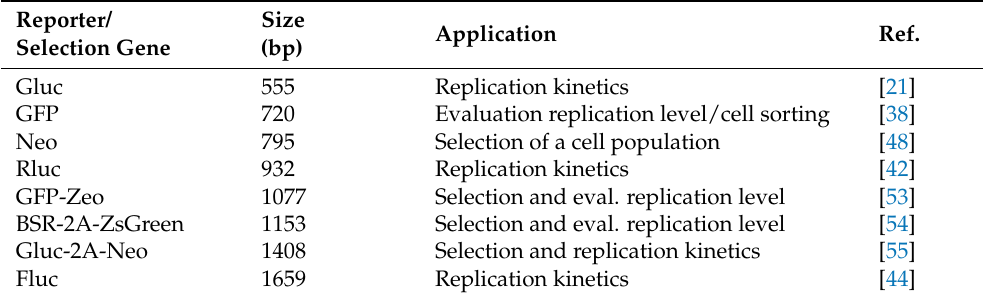
Table 1. Reporter and selection genes used in HEV replicon constructs. The reference corresponding to the first description of the replicon construct is indicated. BSR, Blasticidin-S resistance; Fluc, Firefly luciferase; GFP, Green fluorescent protein; Gluc, Gaussia luciferase; Neo, Neomycin phosphotrans- ferase II; Rluc, Renilla luciferase; Zeo, Zeocin resistance cassette; and ZsGreen, Zoanthus green fluorescent